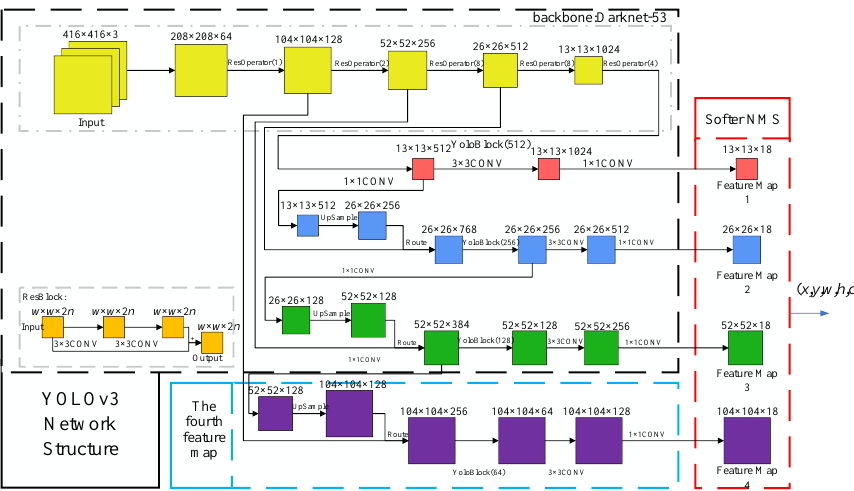
Figure 4. The improved structure of YOLO – Softer NMS.